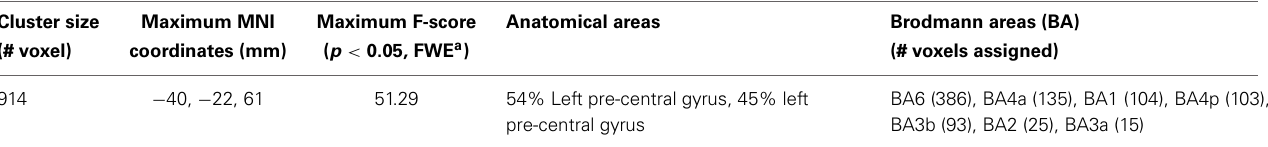
Table 1 | Stimulus onset-based fMRI